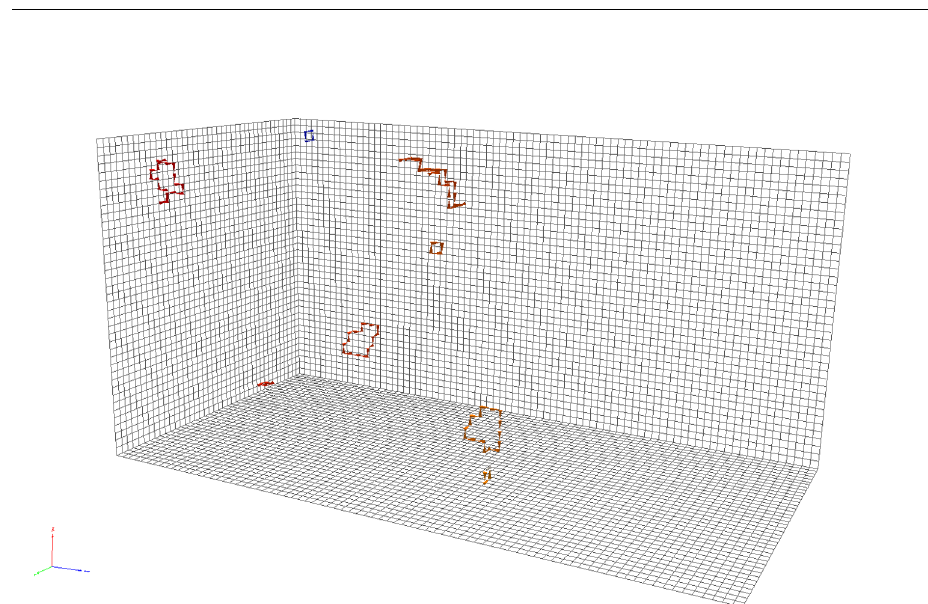
Figure 4. The centre-vortex structure of the secondary loops identified from the pure-gauge configu- ration shown in figure 2. ( Click to activate. )